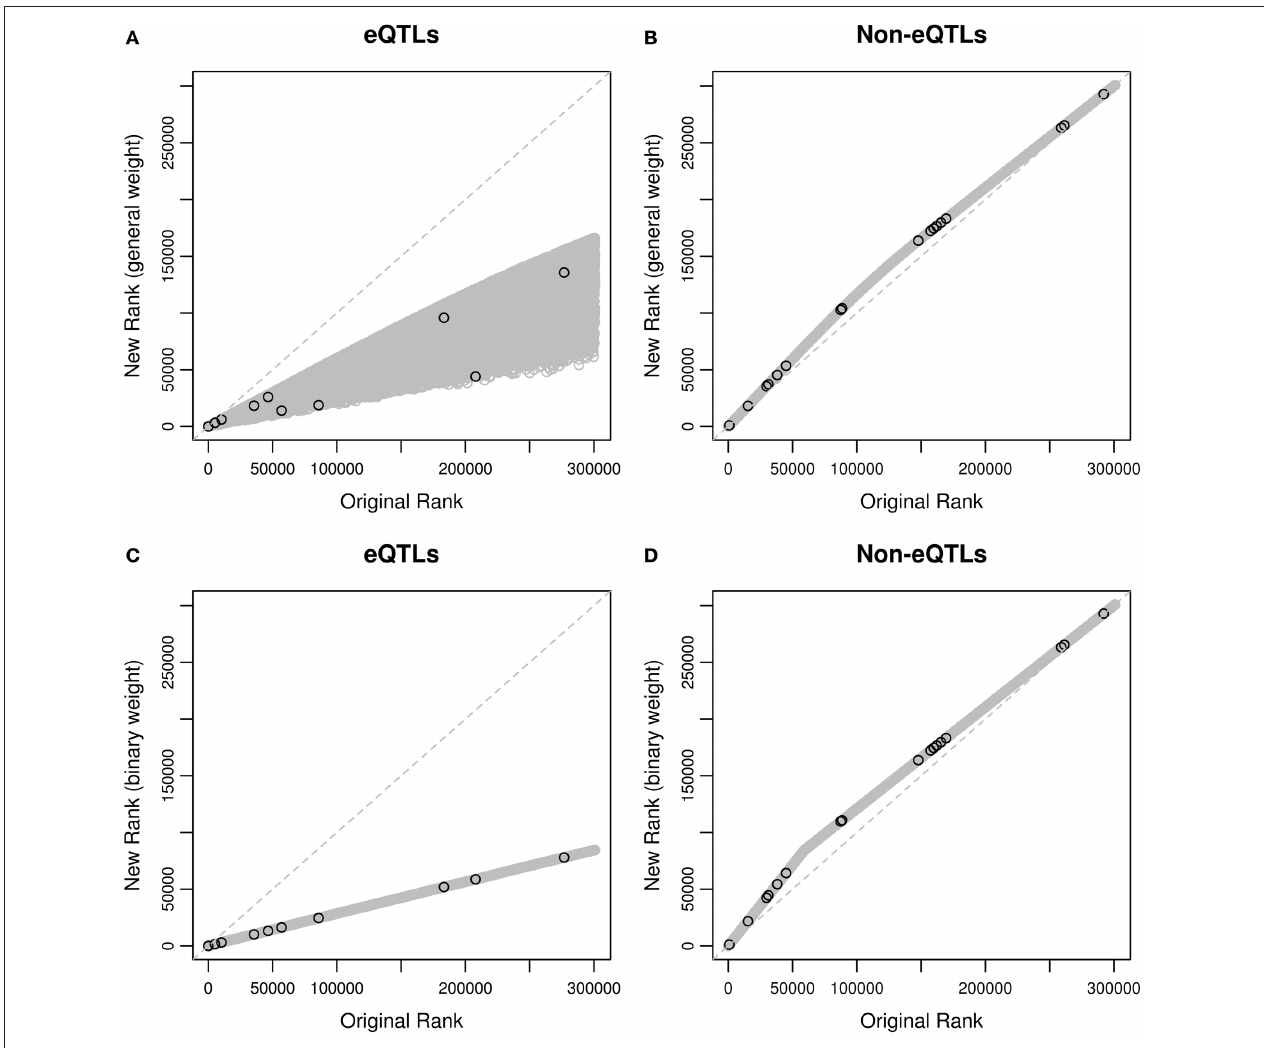
FIGURE 2 | Rankings of the SNPs based on original p -values and weighted p -values in the MAGICS analysis. (A) Original ranks of eQTLs compared to their new ranks based on the general weight; (B) original ranks of non-eQTLs compared to their new ranks based on the general weight; (C) original ranks of eQTLs compared to their